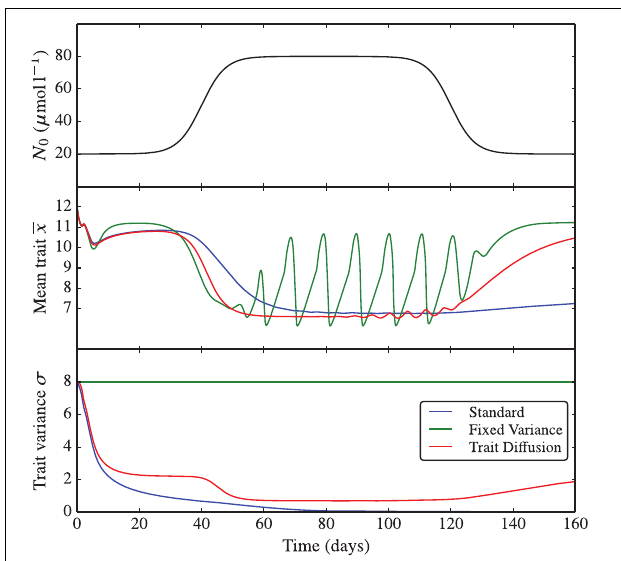
FIGURE 4 | N 0 shock. As nutrient input N 0 is varied from low to high concentrations and back, the underlying dynamics shifts, similarly to the K P shock, from equilibrium to limit cycles and back. The trait diffusion model responds to the environmental perturbation with a dynamical change in trait variance. The corresponding NPZ dynamics is shown in Supplementary Figure 4.